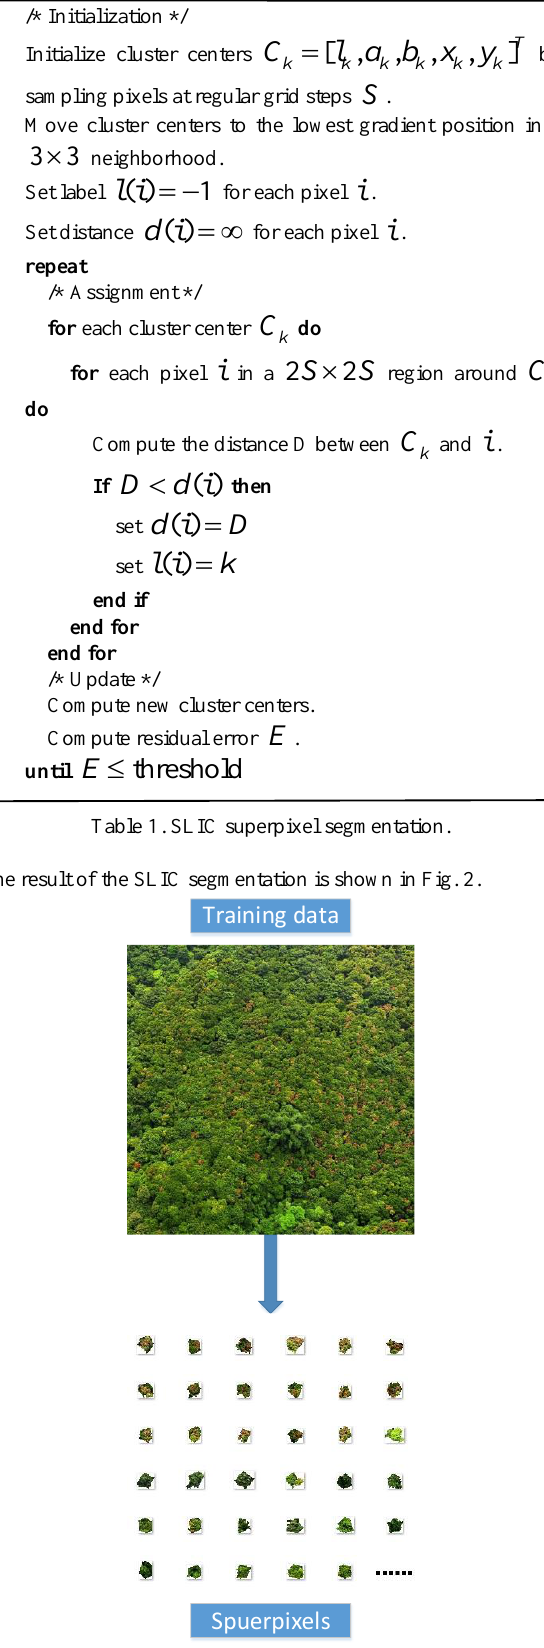
Figure 2. Superpixels segmented by SLIC; the image (top) and the patches (bottom) extracted from the upper image.